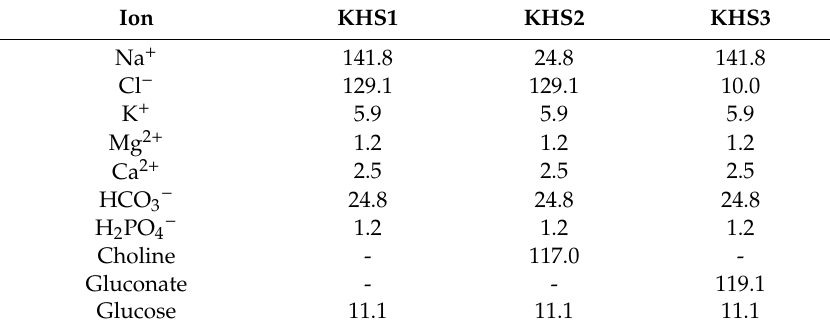
Table 1. Ionic composition of media in mM ( Π ≈ 289 mOsm / kg H 2 O, pH =